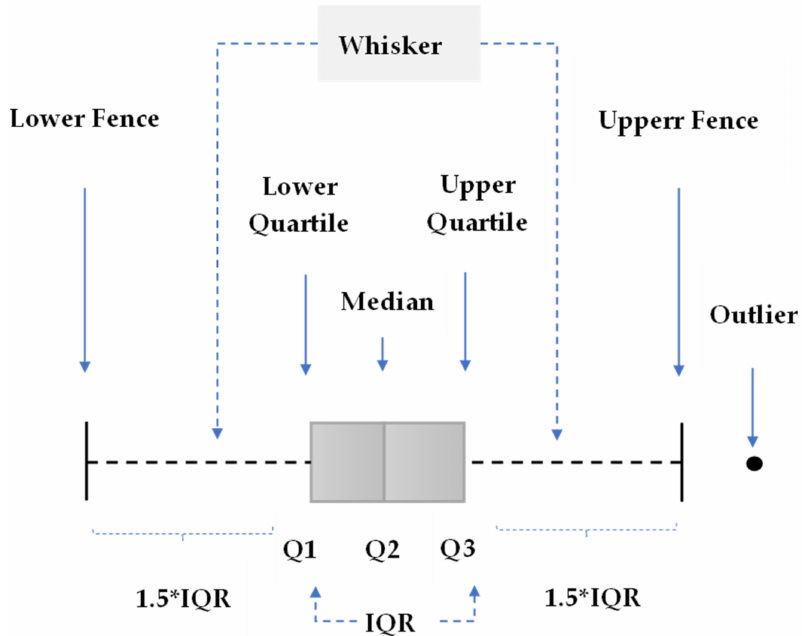
Figure 1. Illustration of a box